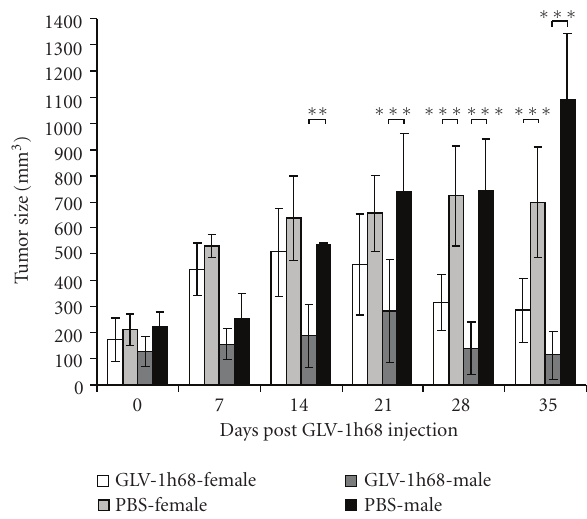
Figure 3: E ff ect of systemic virus injection on tumor growth in PC- 3 xenografted mice of di ff erent genders. Tumor-bearing mice were i.v. injected with either a single dose of GLV-1h68 virus (5 × 10 6 pfu, groups no. 1 and no. 3) or with 100 μL PBS (groups no. 2 and no. 4). Tumor volume was monitored weekly. Two-way analysis of variance (ANOVA) with Bonferroni posttest was used to compare the two corresponding data points of the two groups. P < .05 was considered as statistically significant ∗ P < . 05; ∗∗ P < . 01; ∗∗∗ P < . 001. Male mice: groups no. 1 and no. 2, female mice groups no. 3 and no.